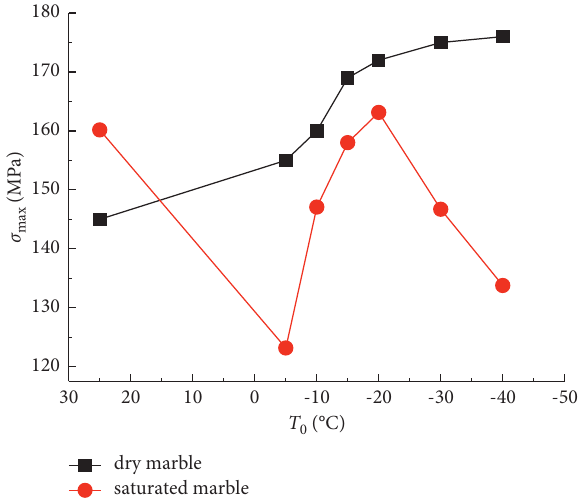
Figure 11: Variation of the peak stress of saturated and dry marble with temperature.